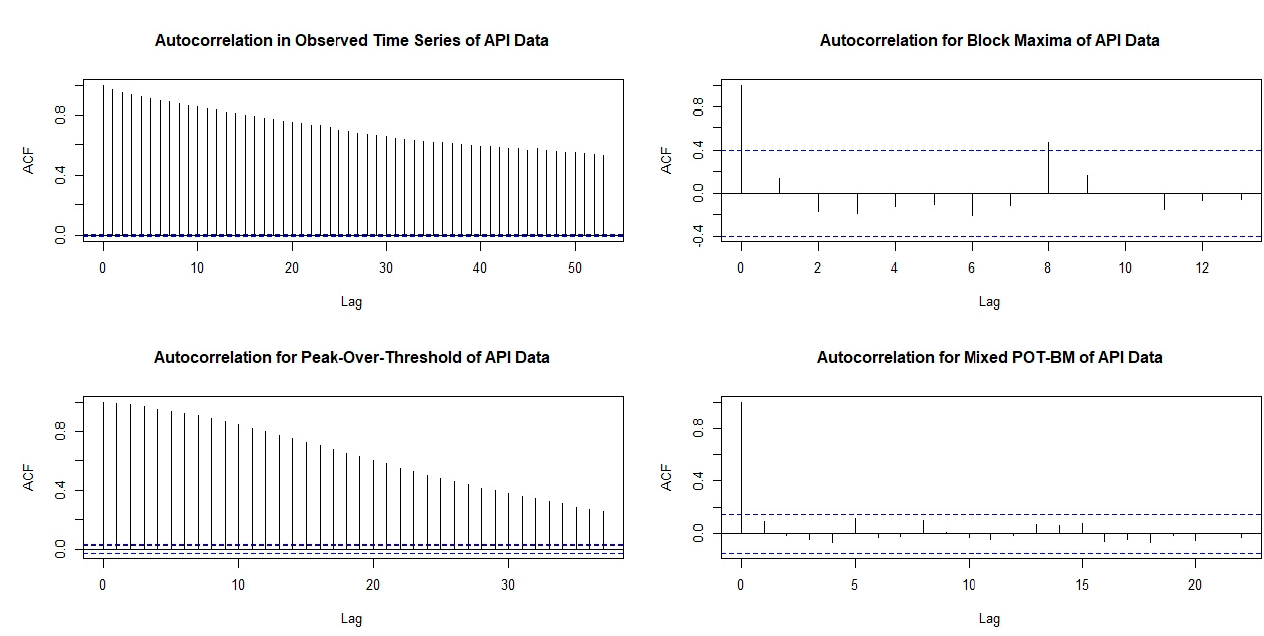
Figure 6. PP plot for each fitted model.